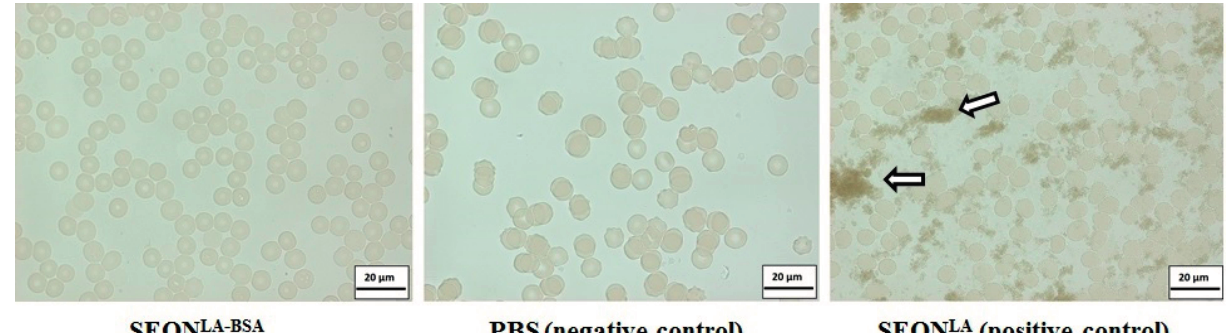
Figure 6. Blood stability assays. Exemplary light microscopy images of (from left to right ) concentrated SEON LA-BSA (c(Fe) = 16.9 ± 1.43 mg/mL), PBS and SEON LA (c(Fe) = 17.2 ± 0.69 mg/mL) diluted 1:2 in whole blood stabilized with EDTA. The arrows mark exemplary particle aggregates.